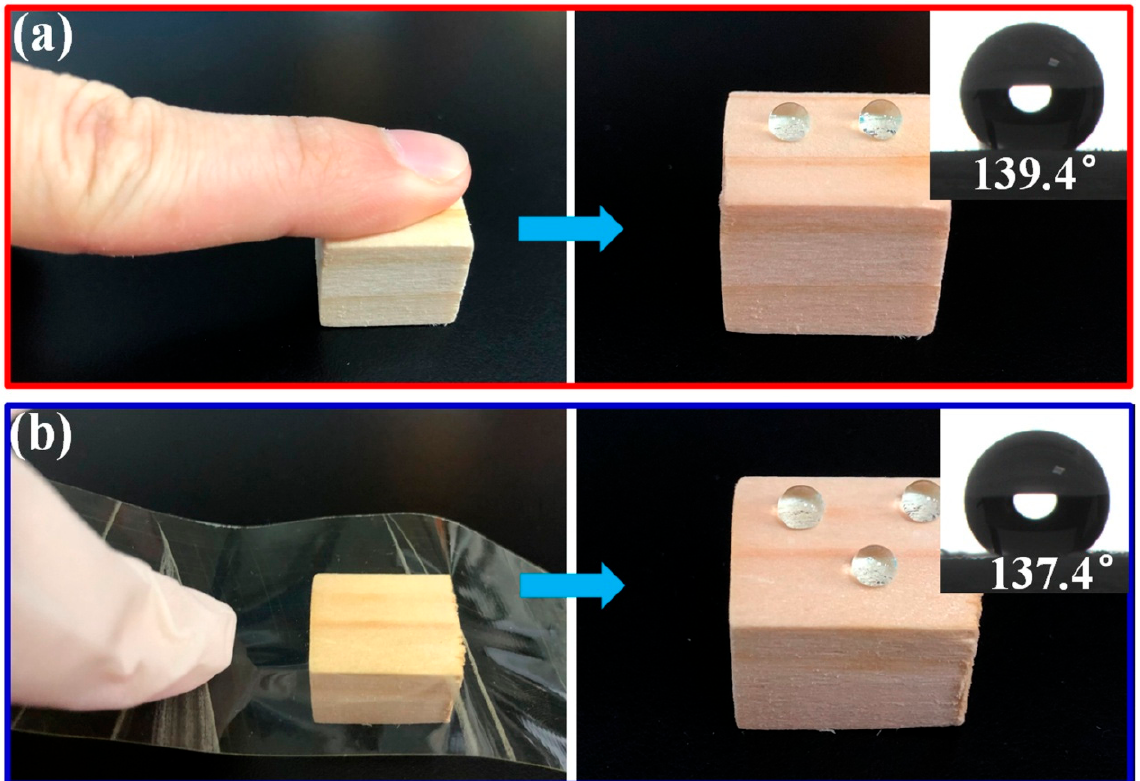
Figure 6. Images of finger wiping test ( a ) and tape peeling ( b ).